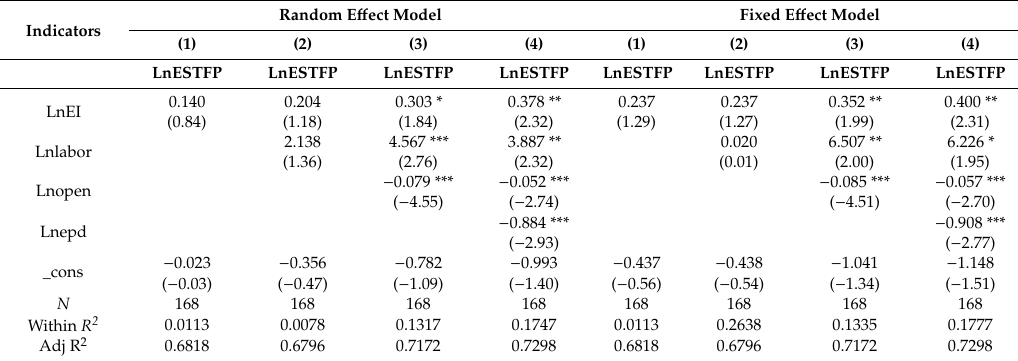
Table 7. Regression Results of Random E ff ect Model and Fixed E ff ect Model.